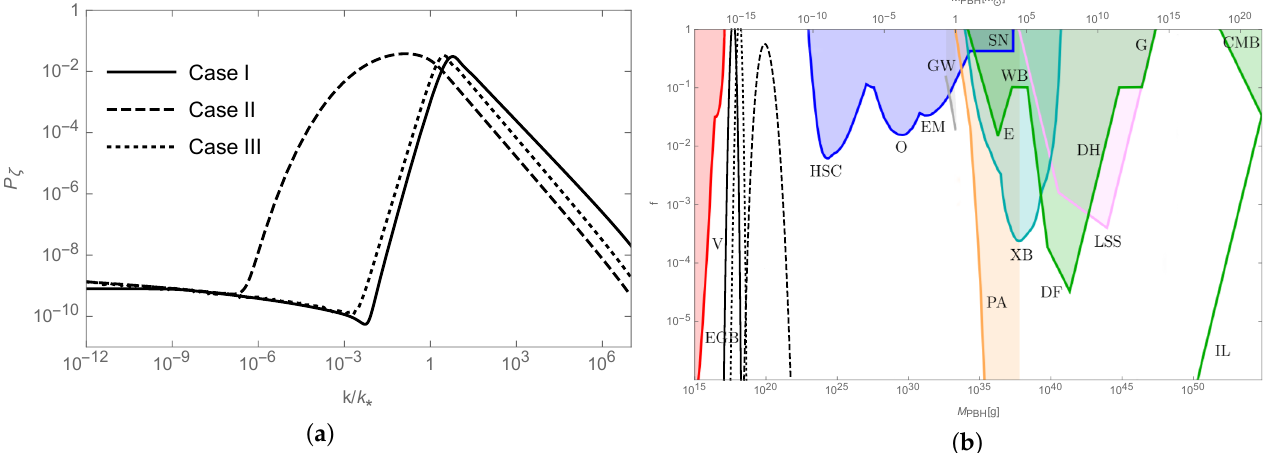
Figure 9. The power spectra in the examples of Table 5 with PBH as the DM, on the left plot ( a ). The k ∗ represents the end of SR and the beginning of USR. The corresponding PBH density fractions are given on the right plot ( b ). The background observational constraints on PBH are taken from Refs. [9,76]. In both plots, the case I is denoted by the solid line, the case II by the dashed line, and the case III by the dotted